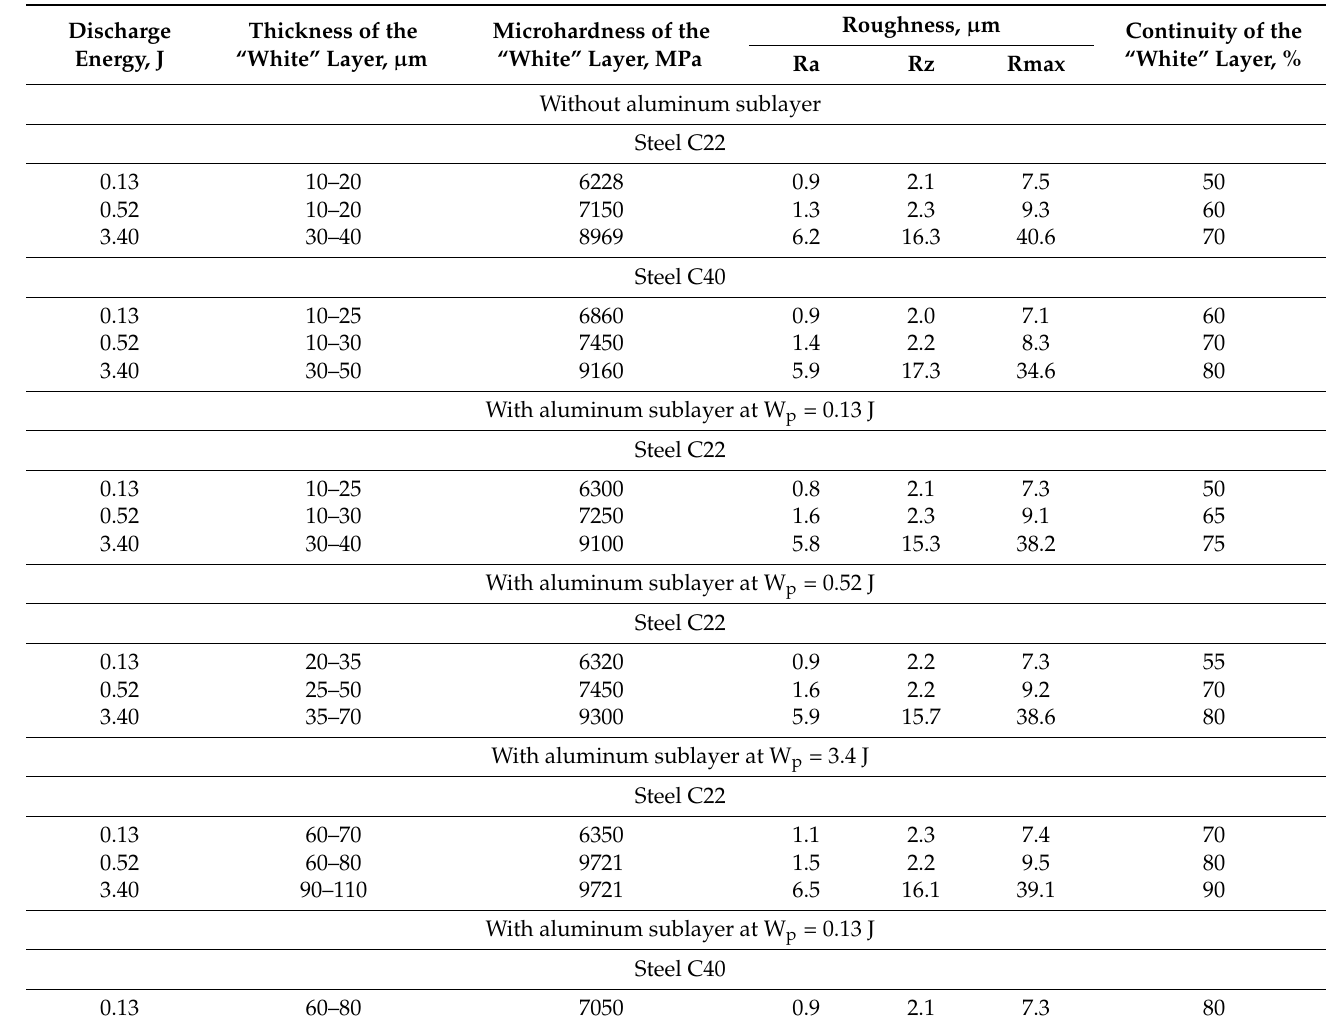
Table 1. The qualitative parameters of the nitrided layers obtained by the ESA process on steel C22 and steel